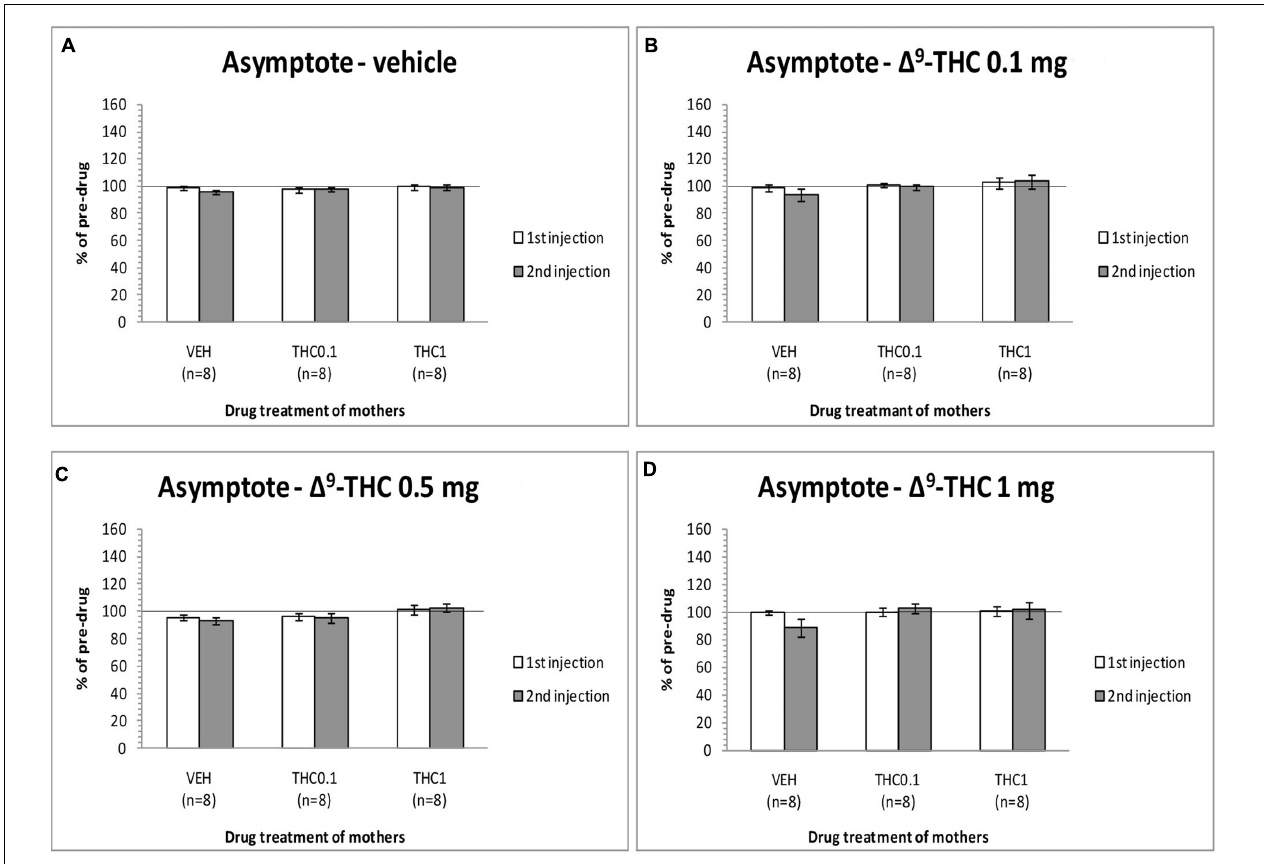
FIGURE 3 | Changes in asymptotic rate of responding in F1 animals, expressed as percentage of predrug value, following acute i.p. administration of 0 mg/kg (A) , 0.1 mg/kg (B) , 0.5 mg/kg (C) , and 1 mg/kg (D) of (cid:49) 9 -THC, during first and second postinjection session. Horizontal axes represent the three groups of F1